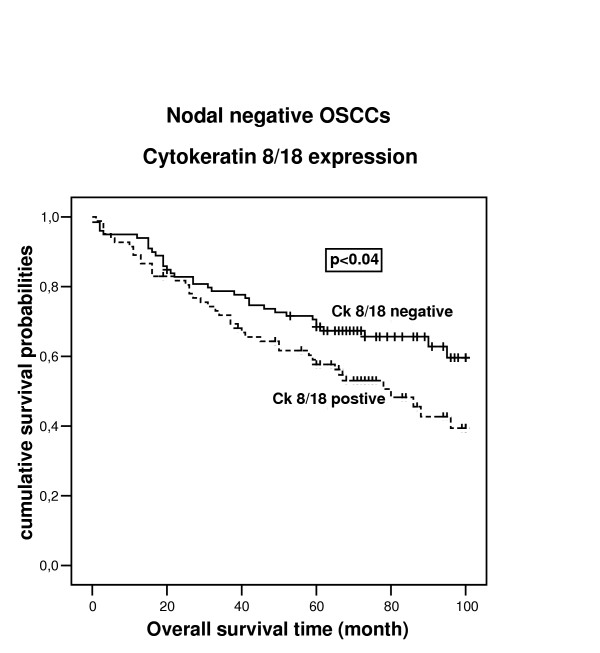
Overall survival of patient with nodal negative oral squamous cell carcinoma in dependence on Cytokeratin 8–18 expression calculated by the Kaplan-Meier method.